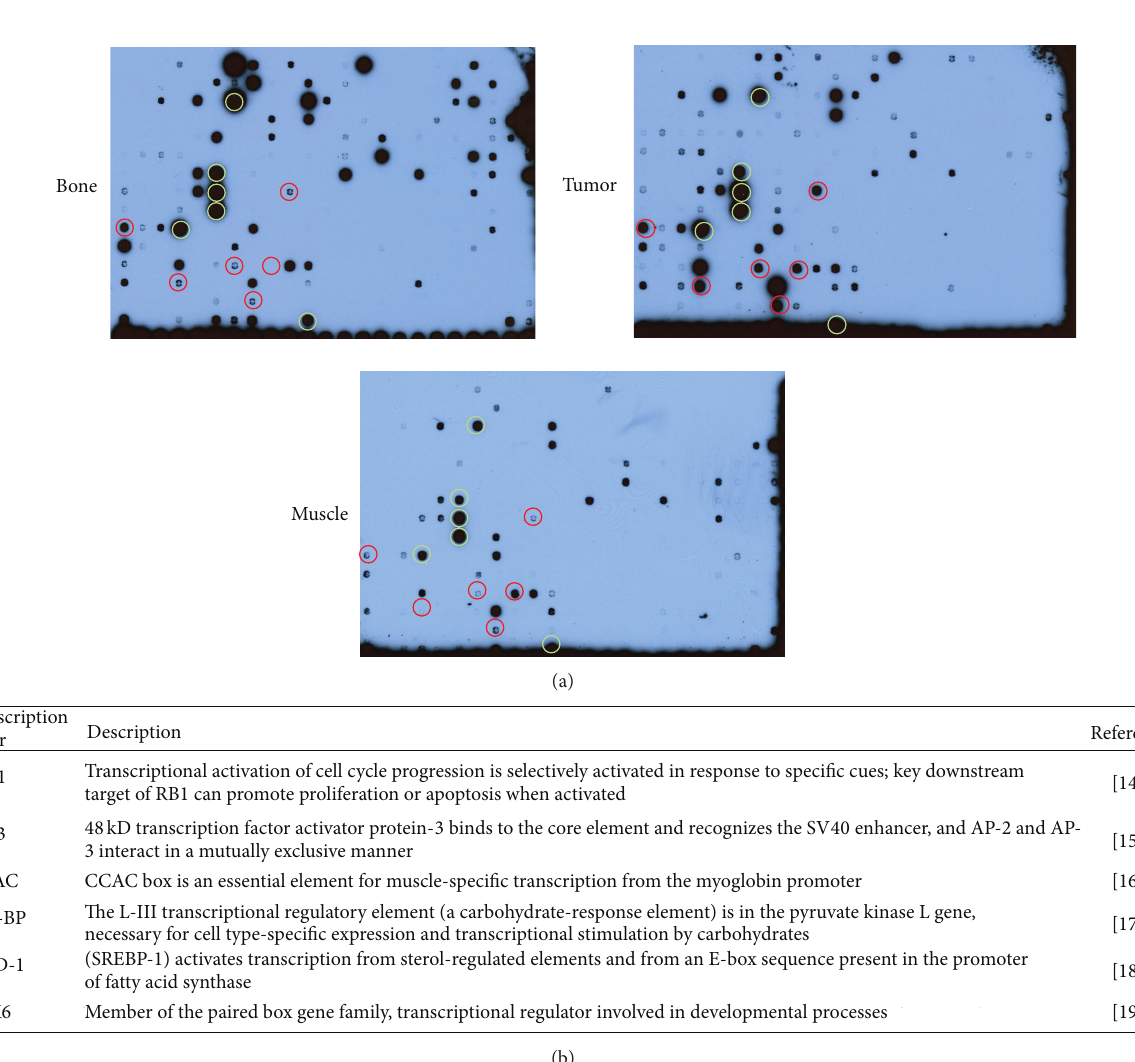
Figure 3: Transcription factor activation. Nuclear extracts from tumor, muscle, and bone were tested for DNA binding activity on a protein- DNA array. (a) Transcription factor binding that was high in all 3 tissues and is therefore considered constitutively active is circled in yellow (left to right, top to bottom: AhR/Amt, GATA1, GATA2, GATA1/2, HIF1, and HOXD8/9/10). Transcription factors that show high binding in the cancer, but not in muscle or bone, are circled in red (left to right, top to bottom: E2F1, AP3, LIII-BP, PAX6, ADD-1, and CCAC). (b) The functions of transcription factors that display high DNA binding in the cancer, but not in muscle or bone, are described.